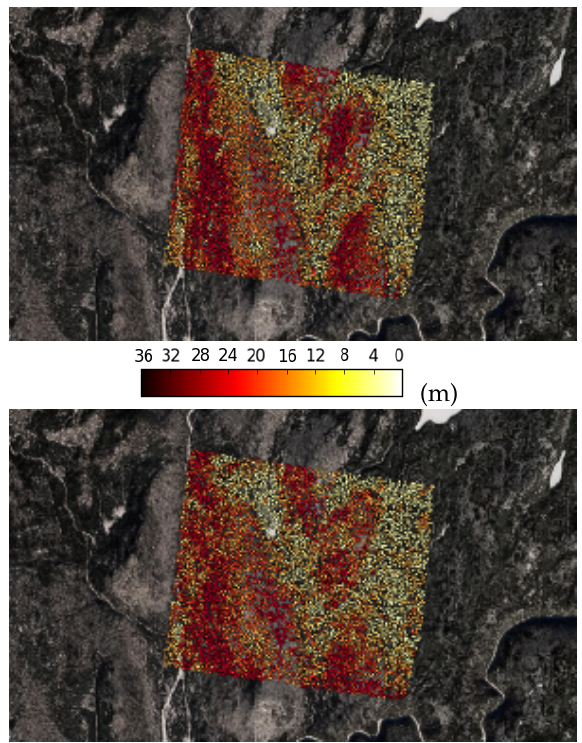
Figure 16. Top : RH100 (m) from LIDAR (m), Bottom : RH100 (m) computed with perceptron from PolinSAR. Table 3. RMSE (m) for tree height estimation with different feature sets.